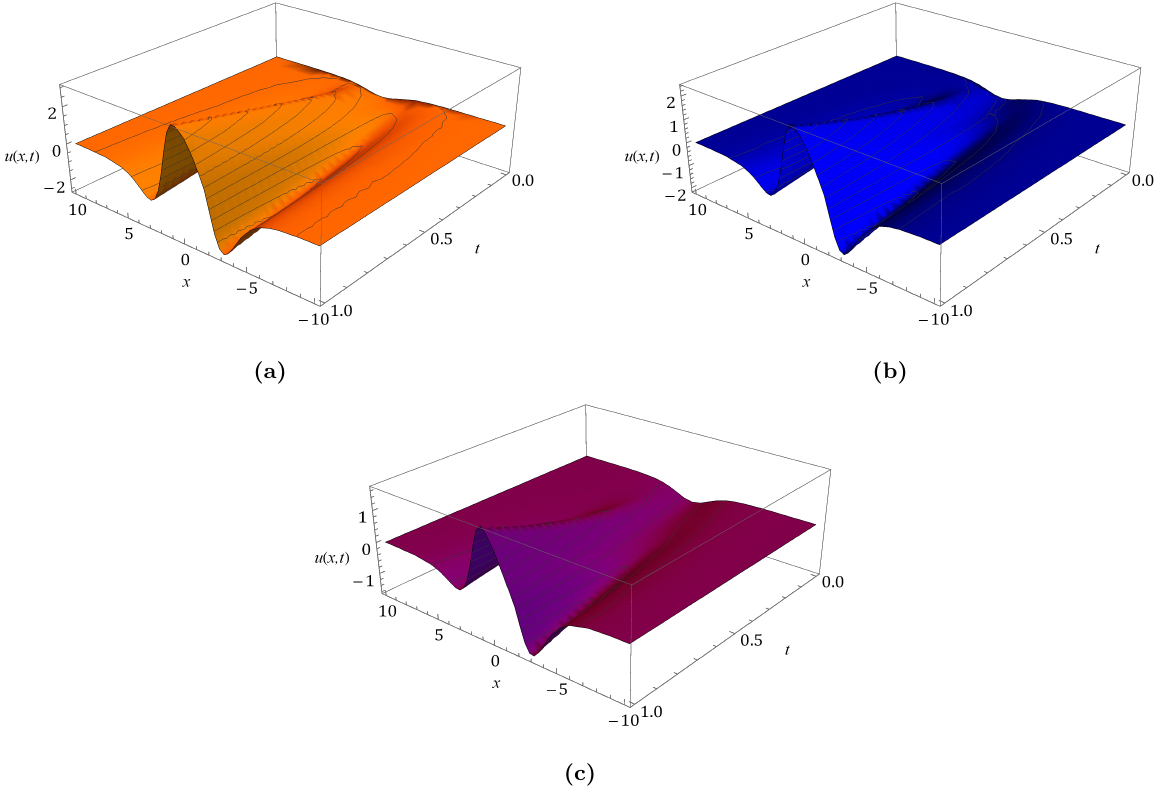
Figure 2. Surfaces of q -HATT solution for ( a ) Caputo, ( b ) CF and ( c ) AB fractional operator at n = 1 , (cid:125) = − 1 , β = 2 , α = 1 and F r = − 1.